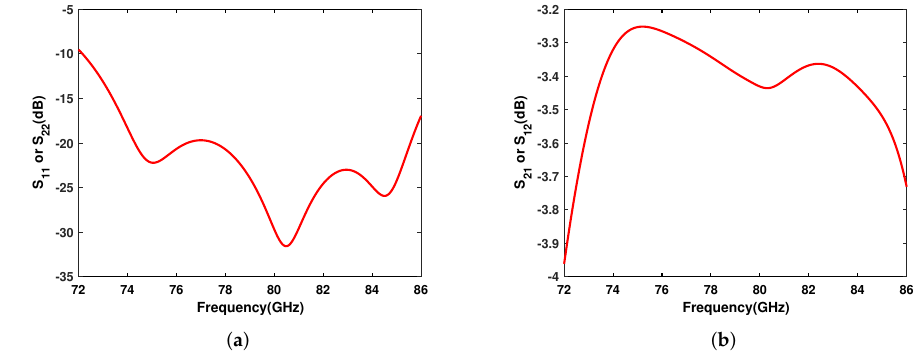
Figure 17. S parameters of the designed delay line structure. ( a ) S 11 or S 22 , ( b ) S 21 or S 12 .